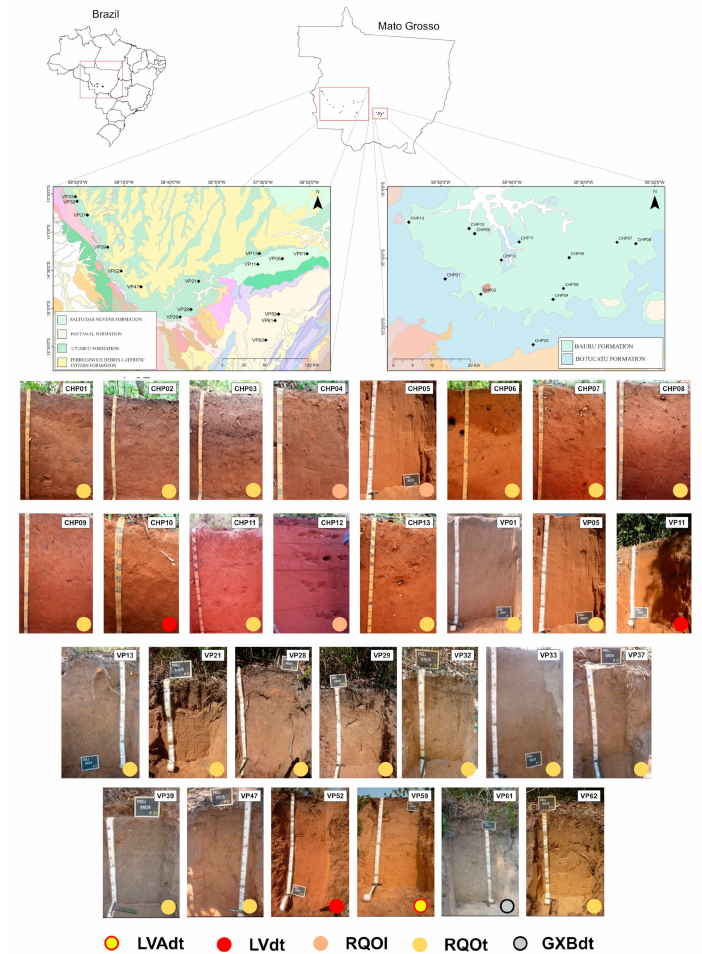
Figure 1. Geographical location, geological formations, pedological classes, and images from the studied profiles: RQOt, Neossolo Quartzar ê nico Ó rtico t í pico; RQOl, Neossolo Quartzar ê nico Ó rtico latoss ó lico; LVdt, Latossolo Vermelho Distr ó fico t í pico; LVAdt, Latossolo Vermelho Amarelo Distr ó fico t í pico; and GXBdt, Gleissolo H á plico Tb Distr ó fico t í